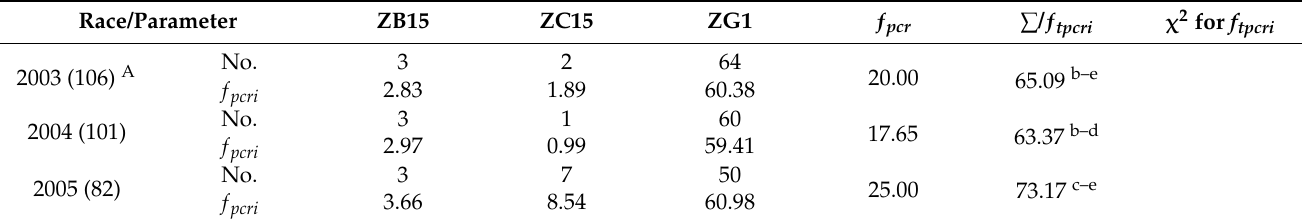
Table 2. Common races of P. oryzae in 14 populations of isolates in Jiangsu province from 2003 to